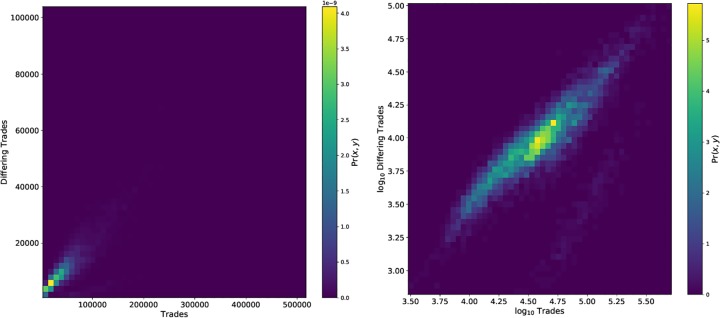
Left: A bivariate empirical distribution function for total trades and number of differing trades. Right: The same distribution, but with logged axes. We might expect a priori that they are related by a constant proportion and hence should observe a fit log10 total trades = c + log10 differing trades, where c < 0. Though there is good evidence of this linear relationship, we see there is a non-negligible area of higher total trades with markedly sub-linear scaling of differing trades.